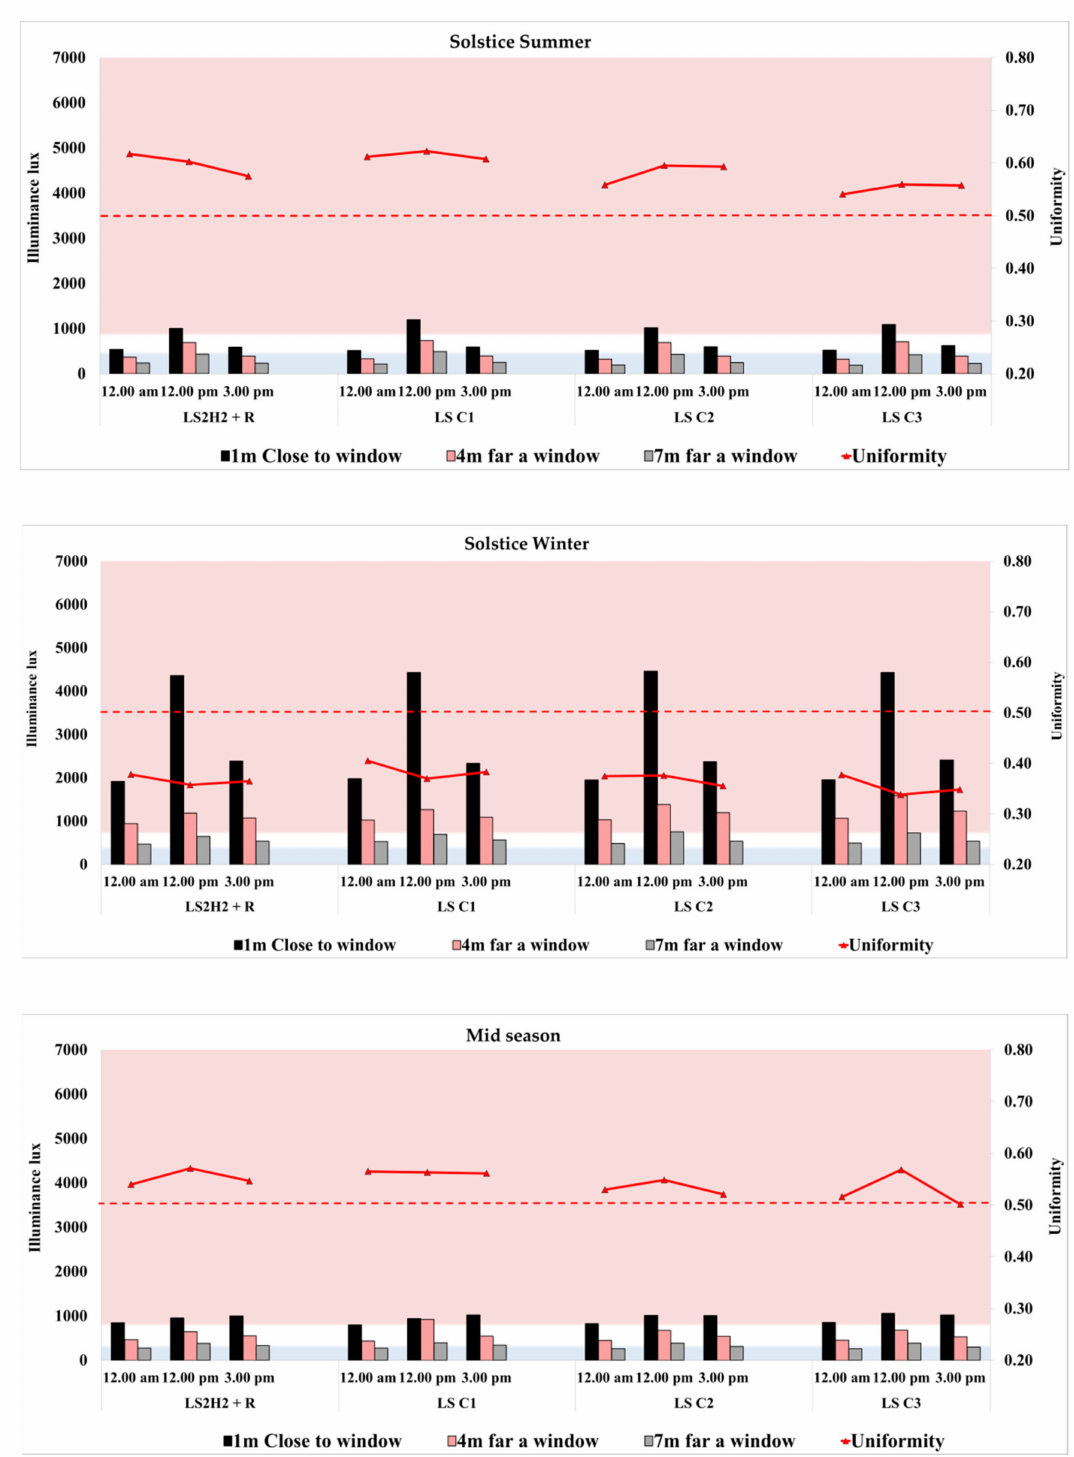
Figure 8. The performance of various curved light shelves in distance of 1 m, 4 m and 7 m from the window and